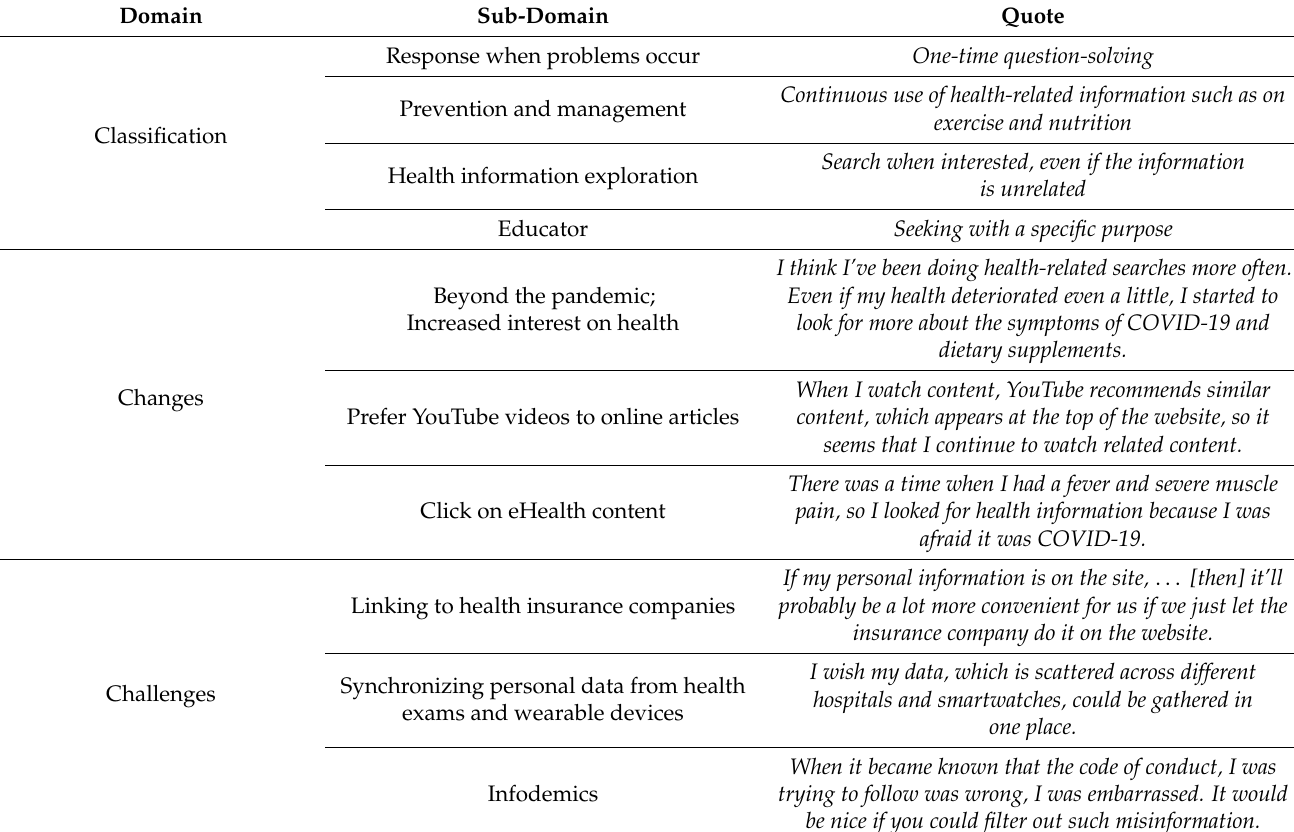
Table 4. Content analysis on participants’ experiences of the online health information